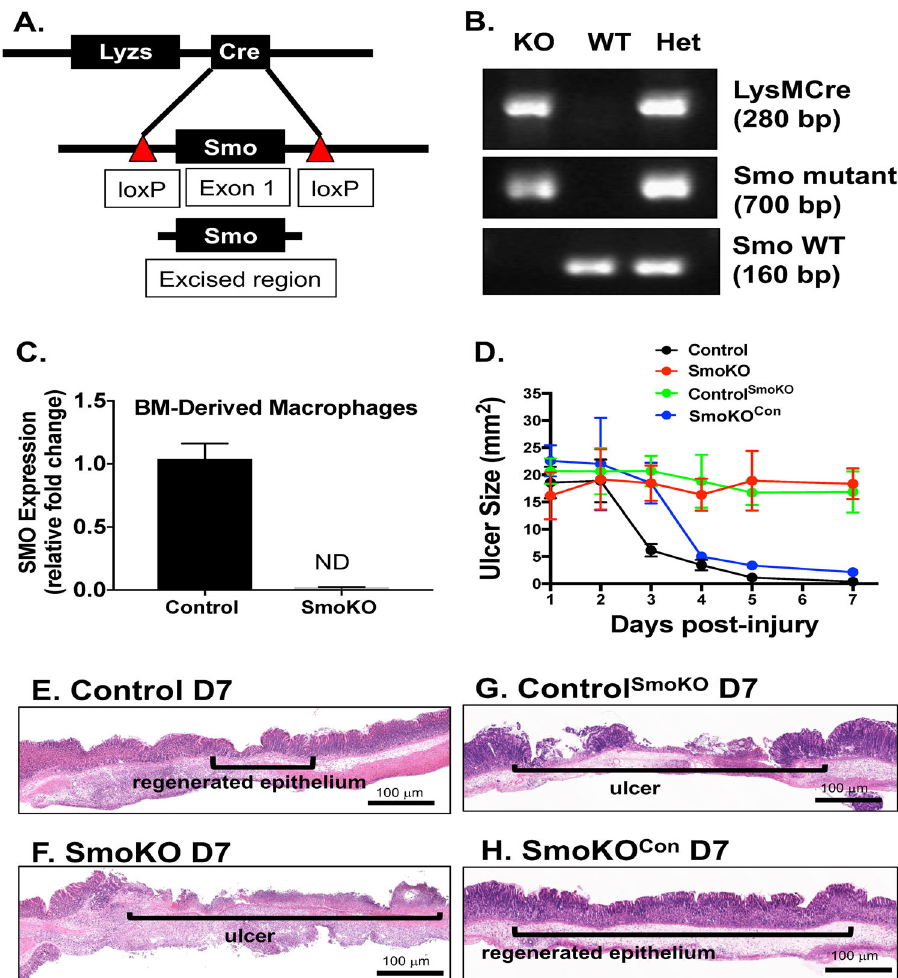
Fig. 1 Generation of LysMCre/SmoKO mice. A The LysMCre/SmoKO mice were generated by crossing the LysMCre with the Smo fl x/ fl x. The LysMCre knock-in allele has a nuclear-localized Cre recombinase inserted into the lysozyme 2 gene (Lyz2). When crossed with Smo fl x/ fl x mice, that have loxP sites fl anking exon 1 of the Smo gene, Cre-mediated recombination results in deletion of the targeted gene in the myeloid cell lineage. Deletion of Smo was analyzed by B genotyping, and C PCR using RNA extracted from bone marrow-derived macrophages. D Ulcer sizes (mm 2 ) 1 – 7 days post-injury in control, SmoKO, control mice transplanted with bone marrow-derived from SmoKO mice (Control SmoKO ), and SmoKO mice transplanted with bone marrow-derived from control mice (LysMCre/SmoKO con ). Data are shown as the mean ± SEM. Representative H&E stains of E control, F SmoKO, G Control SmoKO , and H LysMCre/SmoKO con